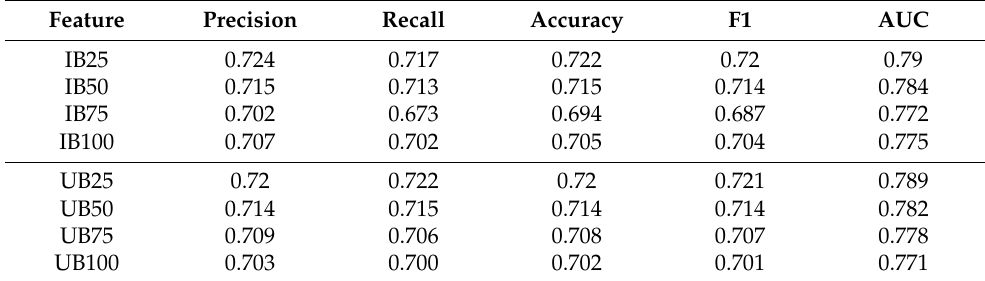
Table 7. Performance of top K